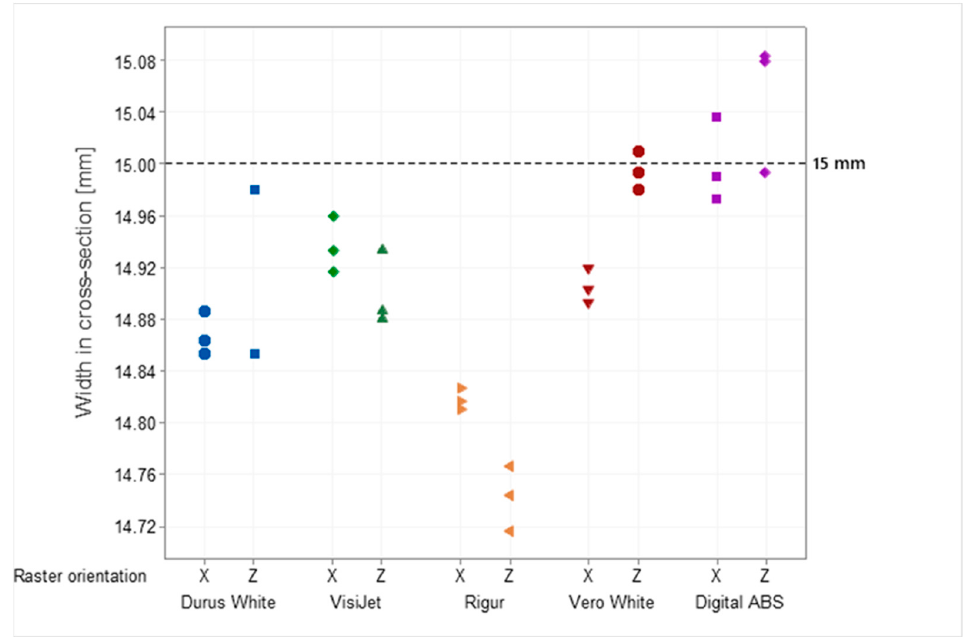
Figure 5. Results of cross-sectional width measurements obtained for Durus, VisiJet, Rigur, Vero, and ABS materials.